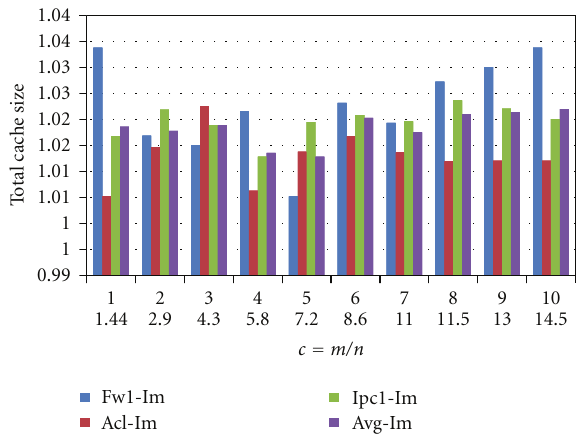
Figure 8: The total size of cache in CCBF normalized to the size of memory in the standard Bloom